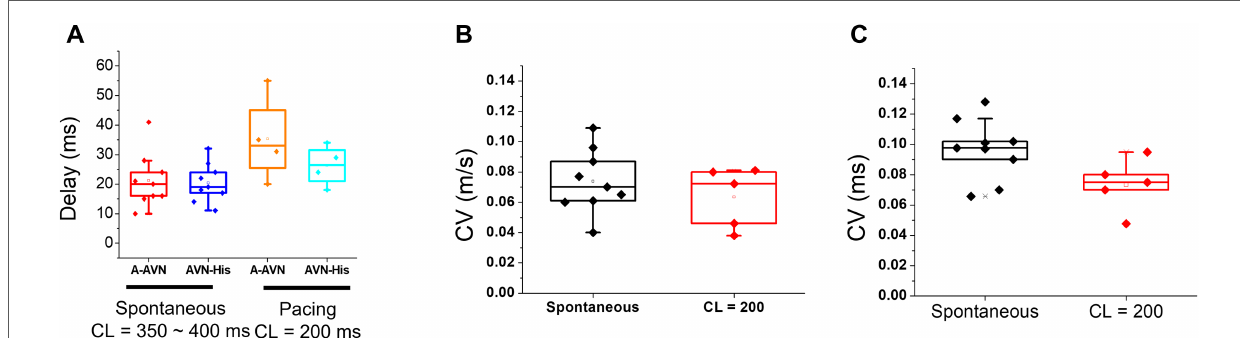
FIGURE 2 Conduction delay and velocity measurements across the AVN during spontaneous rhythm and pacing. ( A ) AV- delay of spontaneous and pacing at a CL (cycle length)=200 ms. The step-delay between the atrial and the AV node APs (A-AVN) is responsible for a major AVN delay. ( B,C ) CVs of AVN conduction were measured using two methods, local vector using a 5×5 window ( B , 0.074±0.021 m/s for the spontaneous beat and 0.063± 0.02 m/s for the paced beat at 200 ms CL) or along the line from the initial AVN AP to the His bundle area ( C , 0.096±0.019 ms for the spontaneous beat and 0.074±0.017 m/s for the paced beat at 200 ms